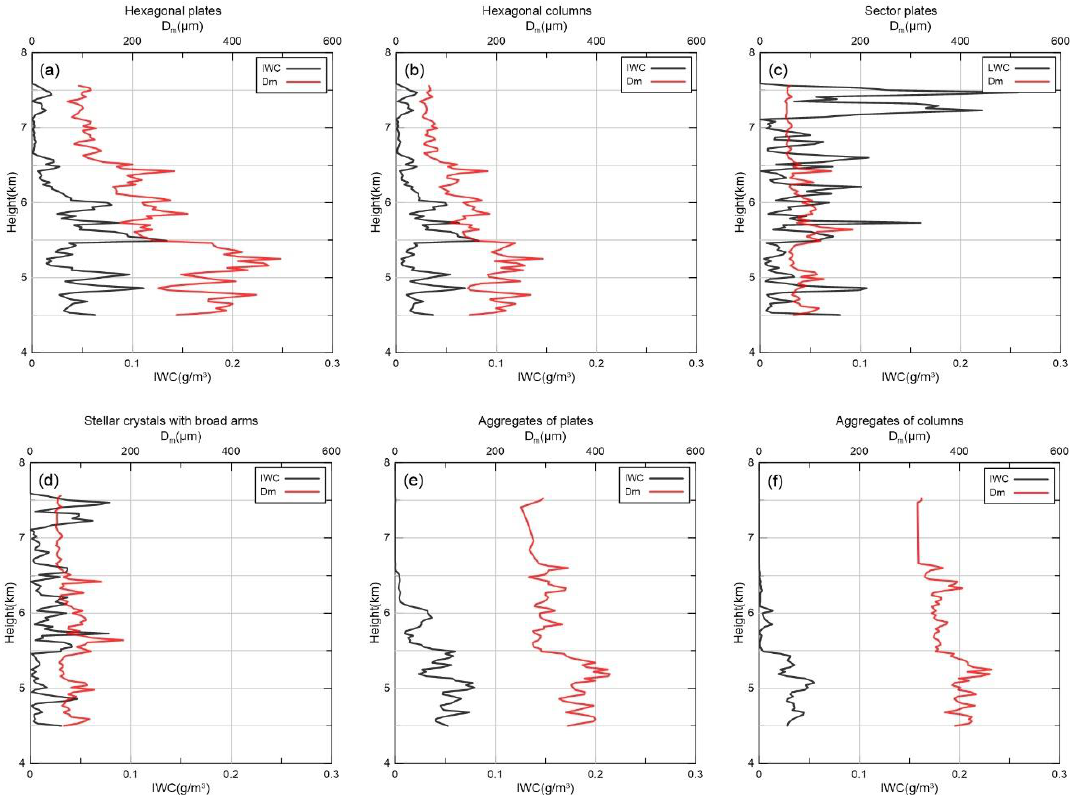
Figure 8. Mean volume-weighted diameter and IWC of different ice crystals retrieved from radar data—hexagonal plates ( a ), hexagonal columns ( b ), sector plates ( c ), stellar plates with broad arms ( d ), aggregates of plates ( e ), and aggregates of columns ( f ).